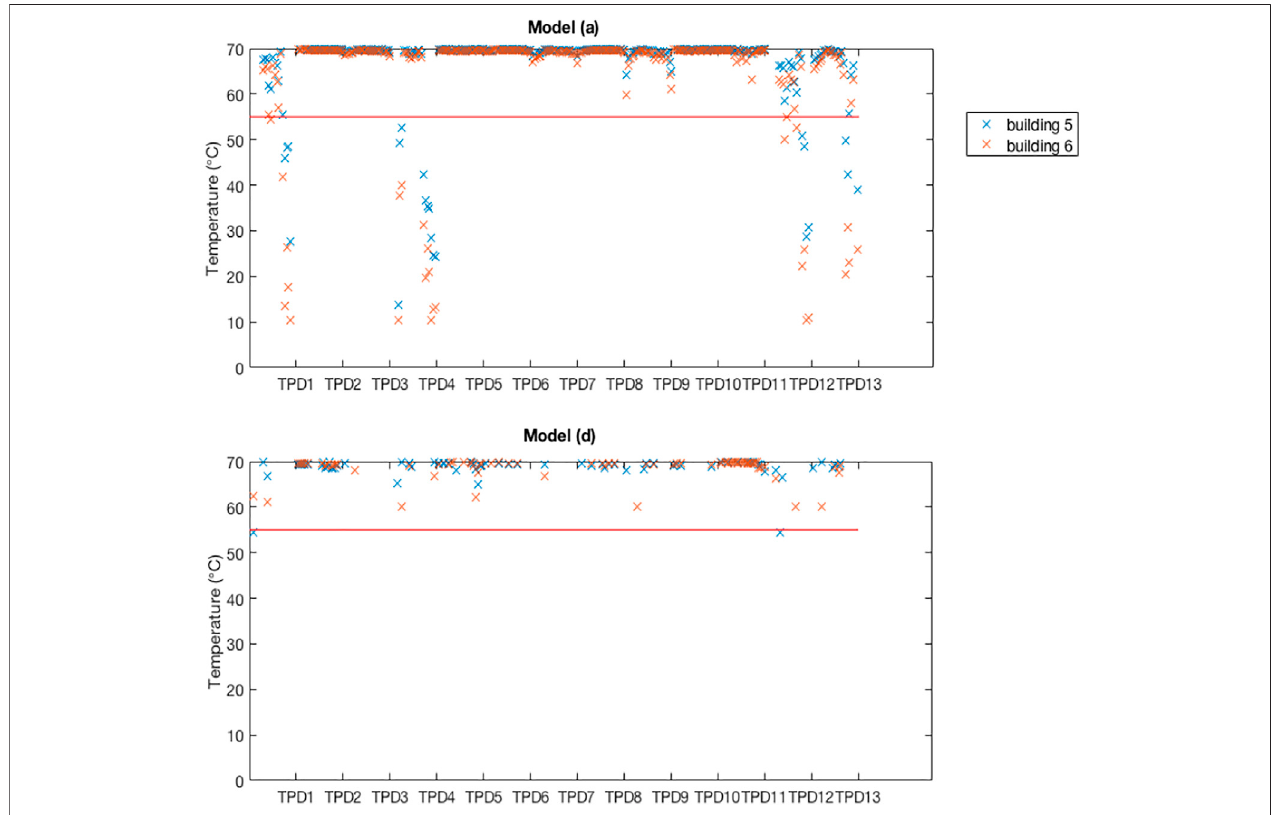
FIGURE 16 | Simulation results of temperature delivered at the building with optimal design given by model (A) (top) and model (D) (bottom) .